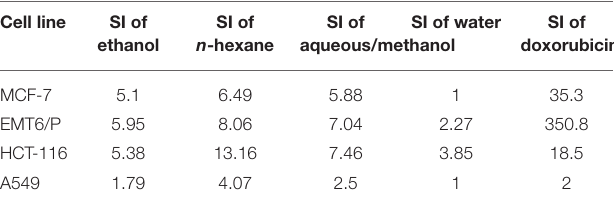
TABLE 8 | The SI of ethanol, n-hexane, aqueous/methanol, and water extracts against MCF-7, EMT6/P, HCT-116, and A549 cell lines. Cell